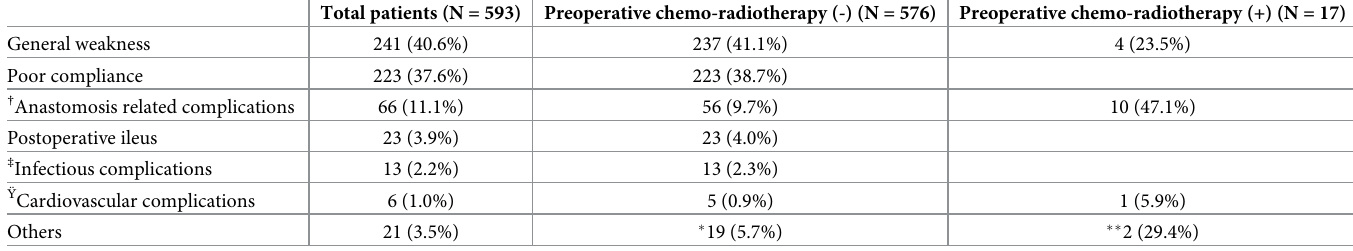
Table 4. Factors preventing early postoperative chemotherapy.